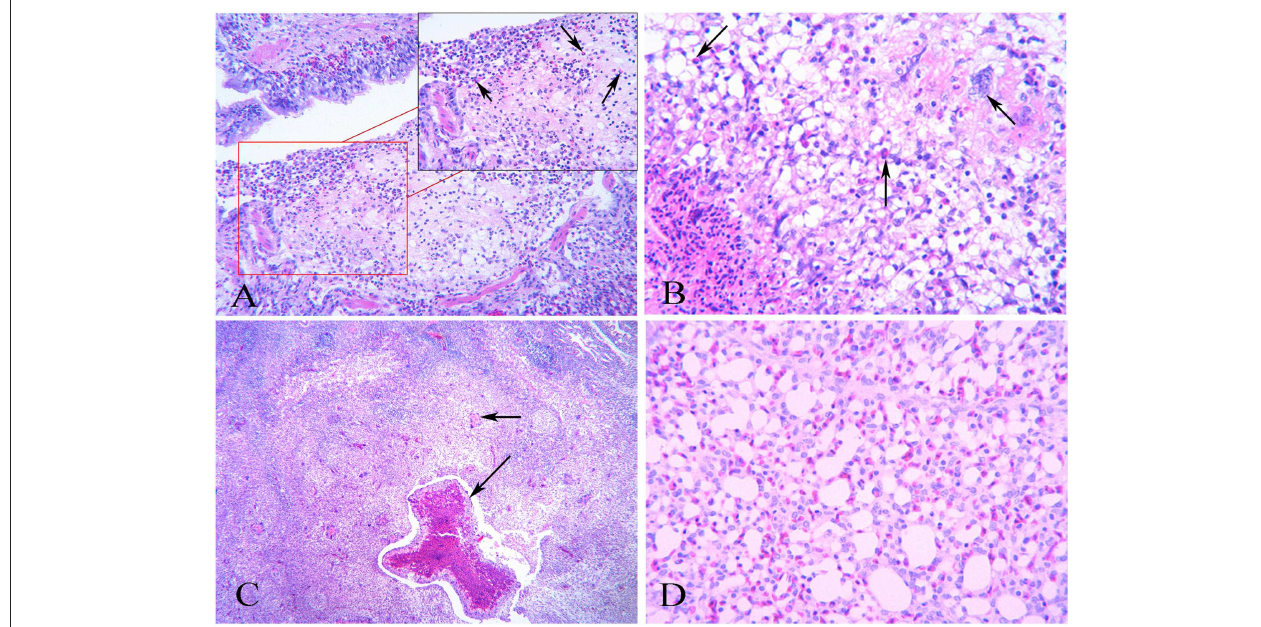
FIGURE 2 | Histopathology of the lungs after infection with Aspergillus fumigatus . Right lungs were sampled in infected and control chickens. (A) At 1 dpi, inflammatory cell infiltration in the parabronchi. Heterophils can be seen (as indicated by the arrow); (B) At 3 dpi, obvious granulomatous inflammation. Arrows indicate inflammatory cells such as heterophils and multinucleated giant cells surrounding the central necrotic area; (C) At 5 dpi, progressive inflammation lesions characterized by small granuloma coalescence in the parabronchi (as indicated by the arrow) and massive inflammatory cell infiltration; (D) The normal histology structure of chicken lungs in the control group.